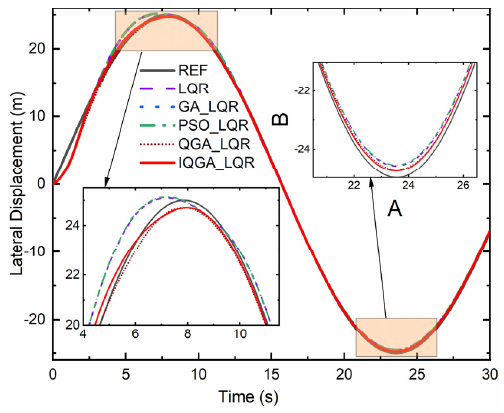
Figure 4. Reference trajectory and actual trajectory.